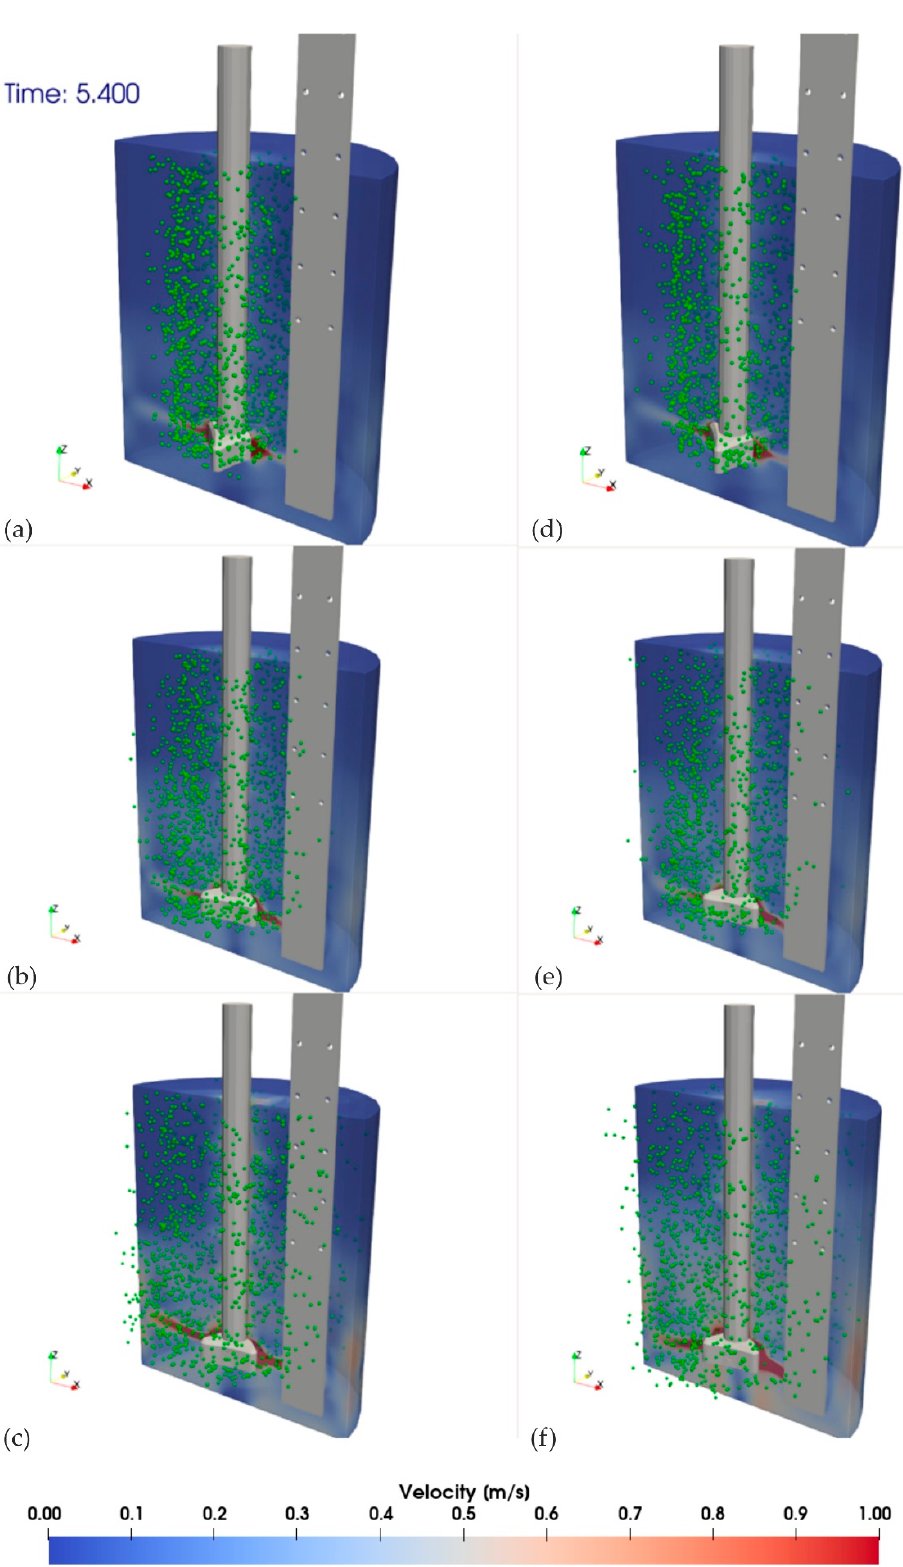
Figure 16. Simulation results of the impeller RT3, for given flows and rotational speeds after a time of 5.4 s.: simulation variants ( a ) A, ( b ) B, ( c ) C, ( d ) D, ( e ) E, and ( f ) F. The numerical simulation results give a good agreement with the experiments per- formed with the physical model. For all studied variants (used process parameters), the